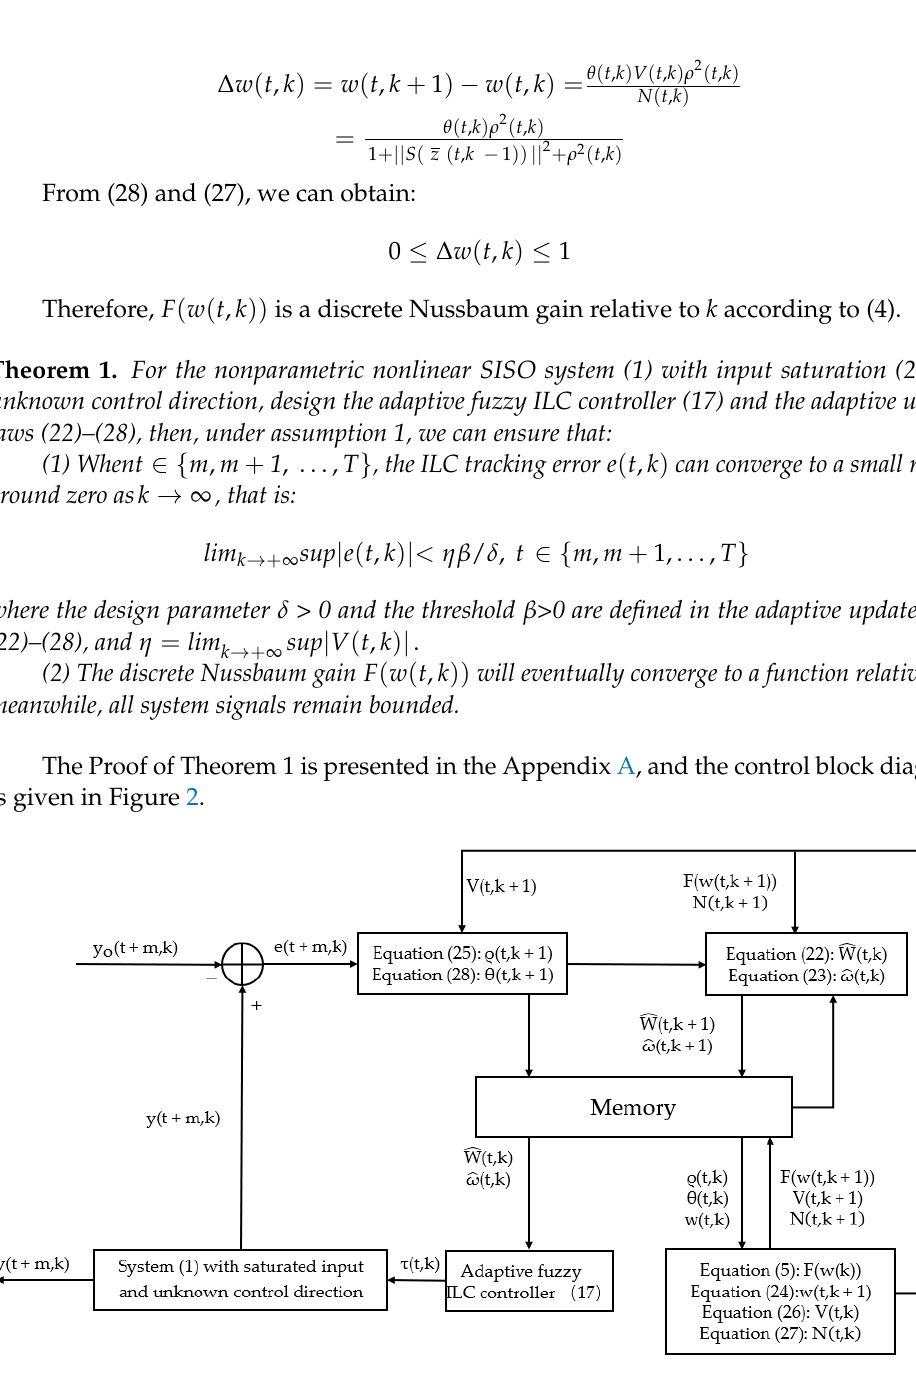
Figure 2. Control block diagram.